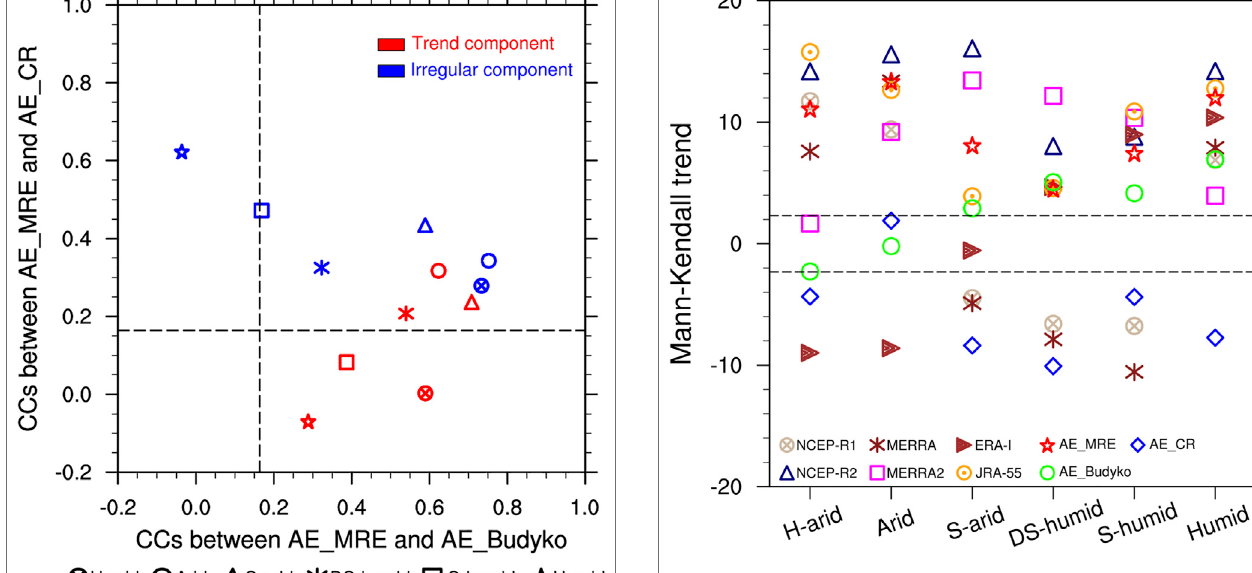
FIGURE 5 | Mann – Kendall trends for X-12-ARIMA trend component ( T t ) of actual evapotranspiration (AE) derived from various datasets for six climatic areas of China from 1982 to 2015. The local 99% con fi dence levels are about ±